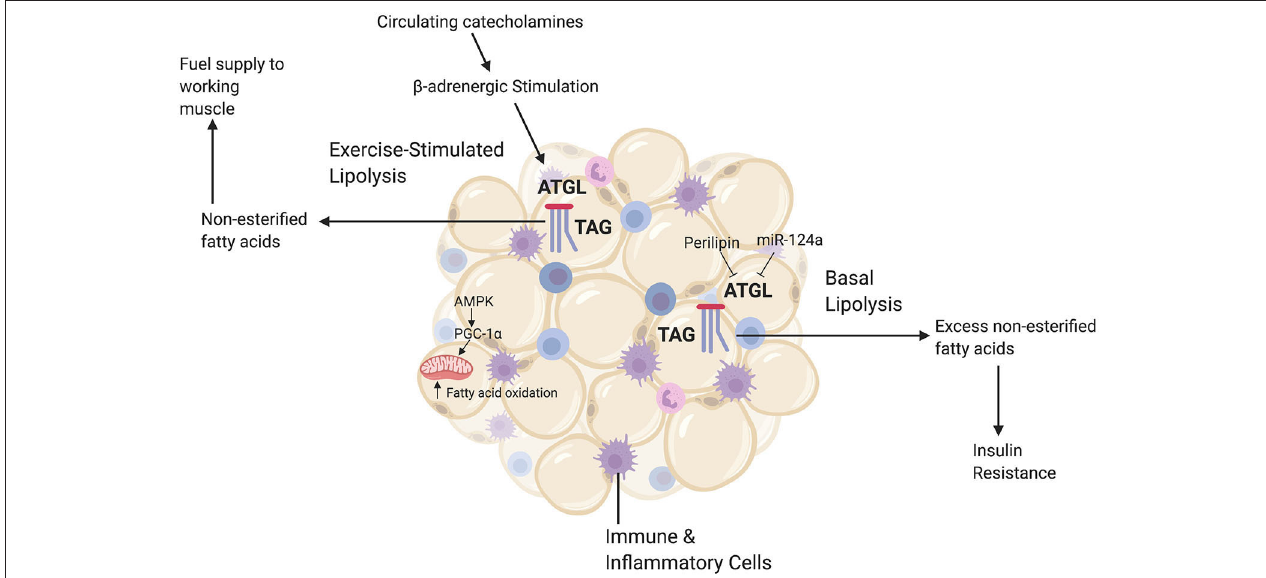
FIGURE 3 | A brief summary of relevant white adipocyte tissue (WAT) functions. White adipocyte tissue has a diverse range of metabolic roles, including the release of signaling hormones and acting as a reservoir for immune and inflammatory cells. The main role of WAT, however, is energy storage. Excess fatty acids are stored in WAT as triacylglycerides (TAGs). When there are increased energy demands, such as during exercise, catecholamines trigger the catabolic enzyme ATGL to break down TAGs via lipolysis and release free fatty acids (or non-esterified fatty acids) to the circulation, which can then be used by skeletal muscle. Additionally, exercise upregulates the energy-sensing molecule AMPK and the master regulator of mitochondrial biogenesis pgc-1alpha. This upregulation increases fatty acid oxidation rates in adipocytes to meet increased energy demands. During basal conditions, however, energy demand is low and ATGL is inhibited by lipid droplet proteins such as perilipin-1 and microRNAs such as miR-124a. When there is an excess of WAT, this careful regulation of lipolysis becomes dysregulated and ATGL breaks down TAGs even when fatty acids are not needed by peripheral tissues. High levels of basal lipolysis lead to poor metabolic health outcomes such as insulin resistance. This figure created with